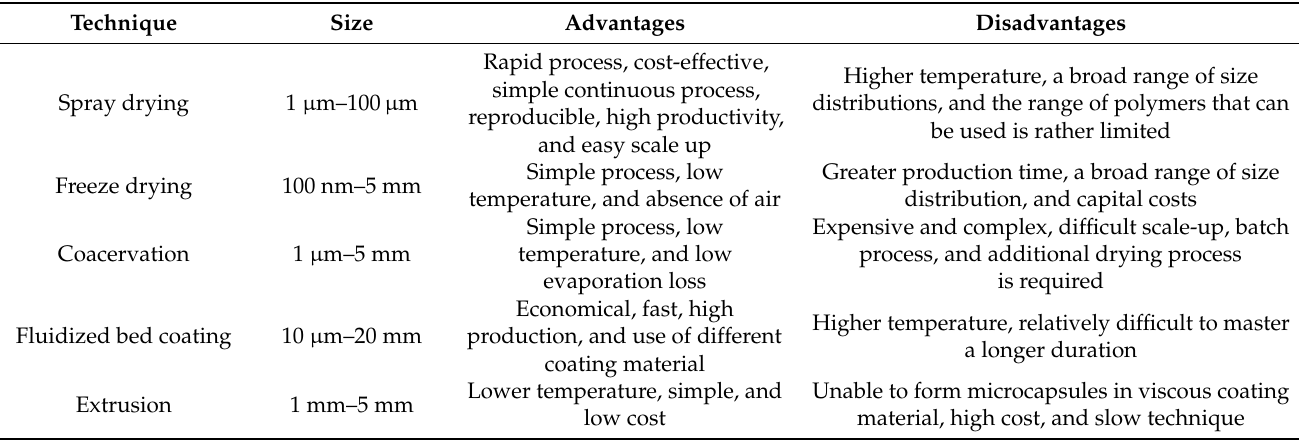
Table 1. Advantages and disadvantages of microencapsulation